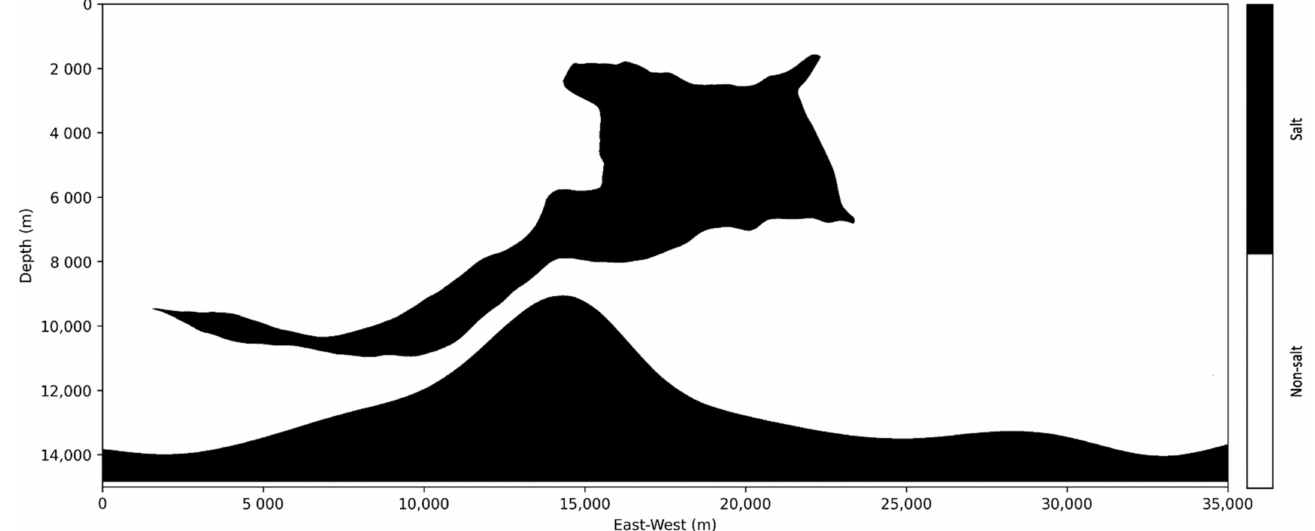
Figure 2. The salt features based on velocity values on the model cross